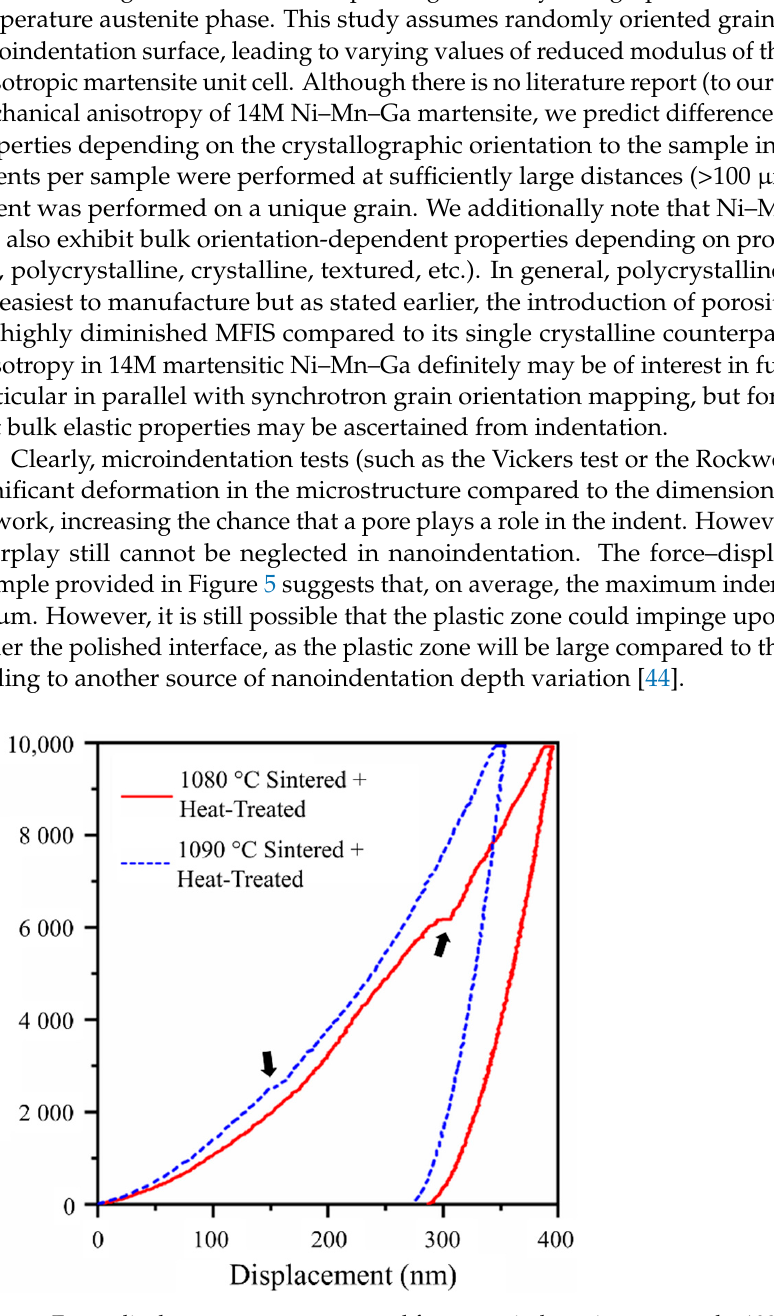
Figure 5. Force–displacement curves extracted from nanoindentation tests on the 1080 ◦ C and 1090 ◦ C sintered and heat-treated samples to display exemplary pop-in observations (see arrows). Larger deformation in the 1080 ◦ C sintered + heat-treated sample corresponds to the smaller hardness value observed between the two samples.